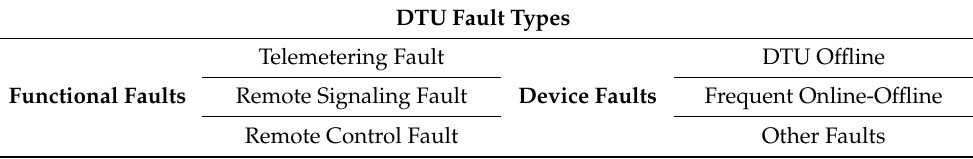
Table 1. DTU fault